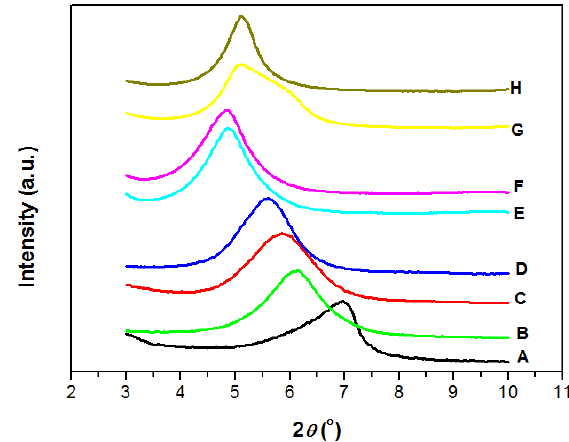
Figure 1. XRD patterns of MMT / PEO hybrids and Pd@MMT / PEO catalytic composites. A. MMT; B. MMT / PEO (90 / 10); C. MMT / PEO (80 / 20); D. MMT / PEO (70 / 30); E. MMT / PEO (60 / 40); F. MMT / PEO (50 / 50); G. Pd 2 + @MMT / PEO (0.2 / 80 / 20); H. Pd 0 @ MMT / PEO (0.2 / 80 / 20).